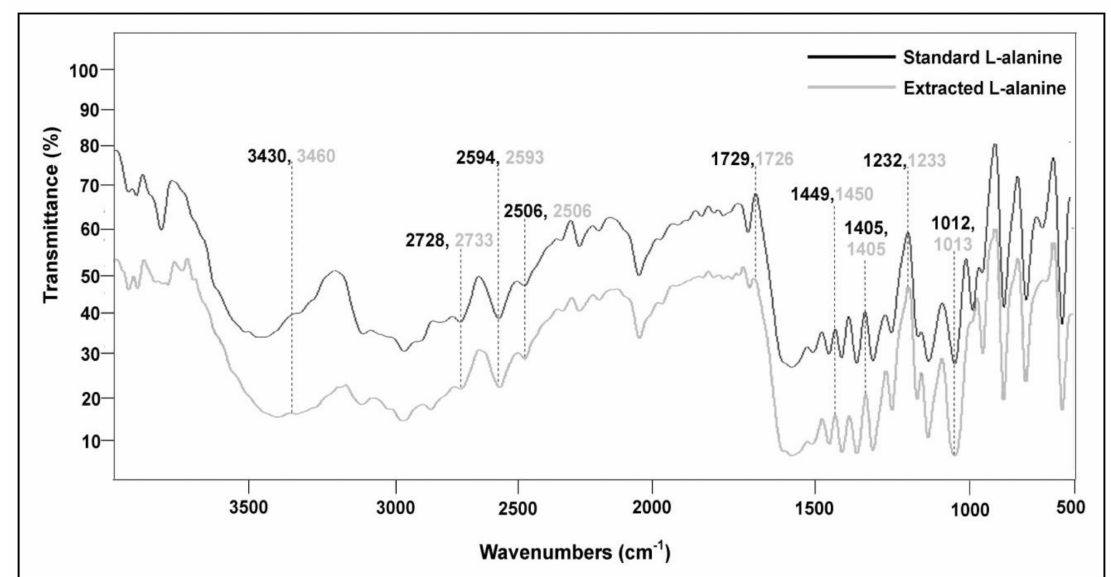
Figure 5. A close similarity in the FTIR spectra of standard L-alanine and L-alanine extracted from the recombinant P. acidilactici BD16 ( alaD + ).